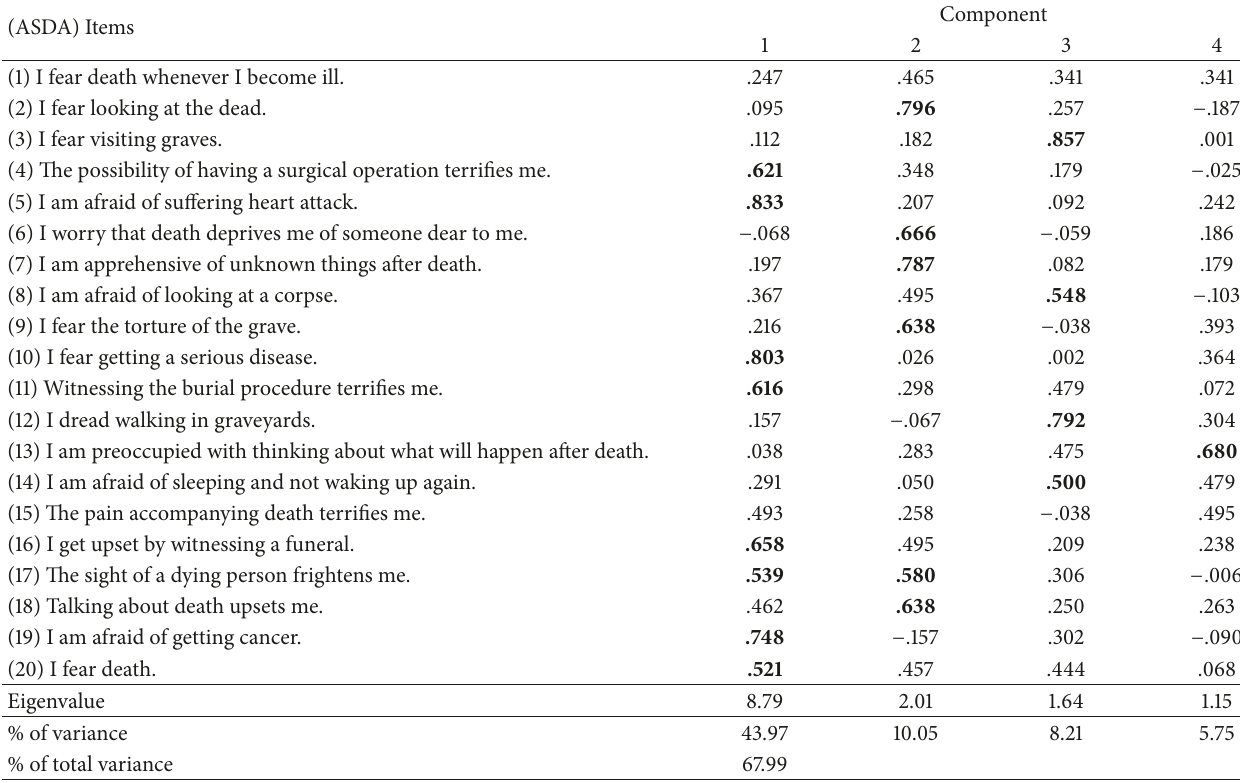
Table 2: Factor loadings of the Farsi version of the Arabic Scale of Death Anxiety (ASDA) in Iranian psychiatric outpatients ( 𝑁 = 52 ). (ASDA) Items